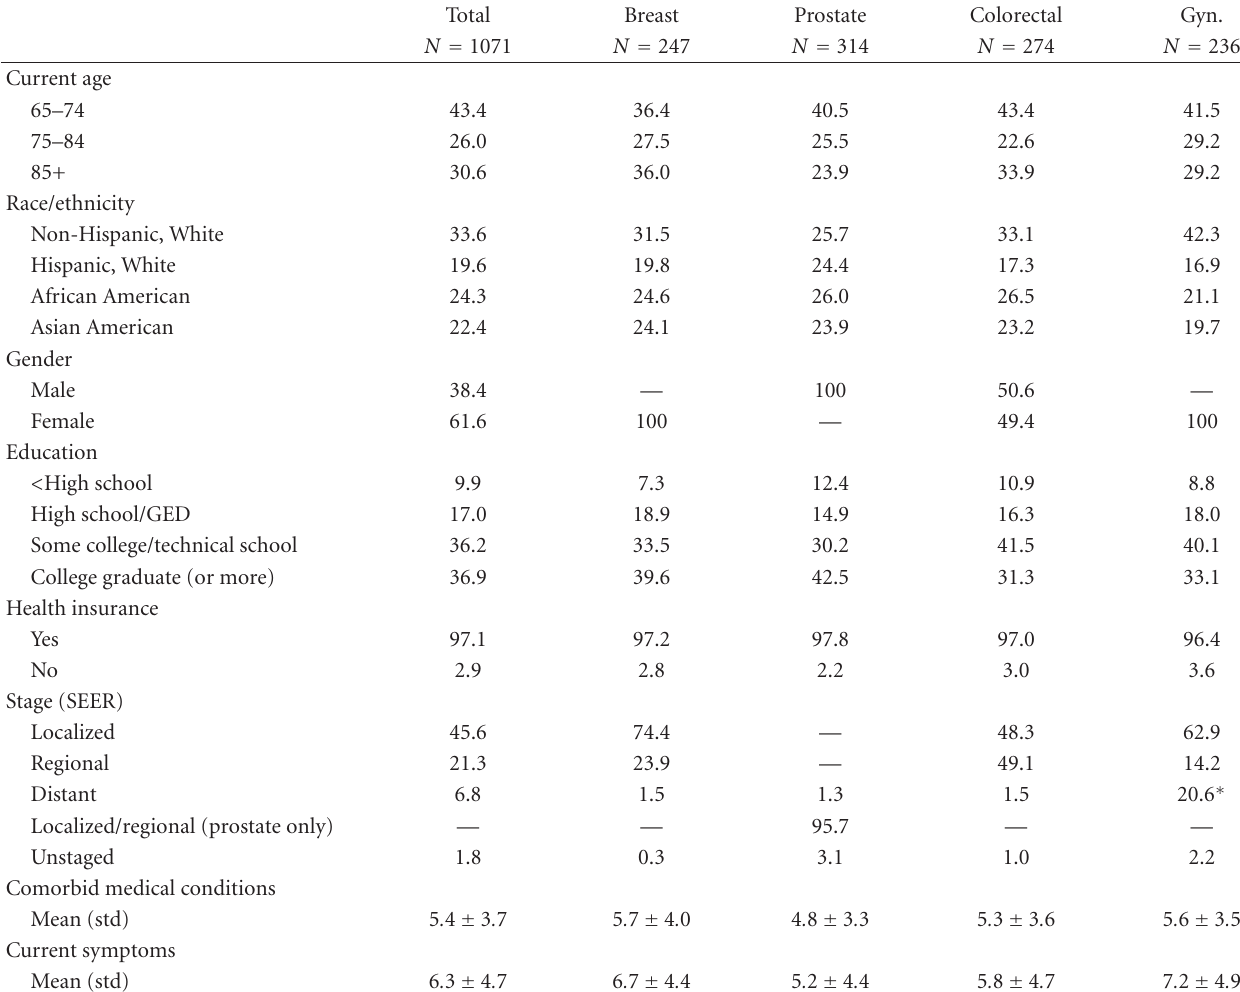
Table 1: Sample characteristics (%).